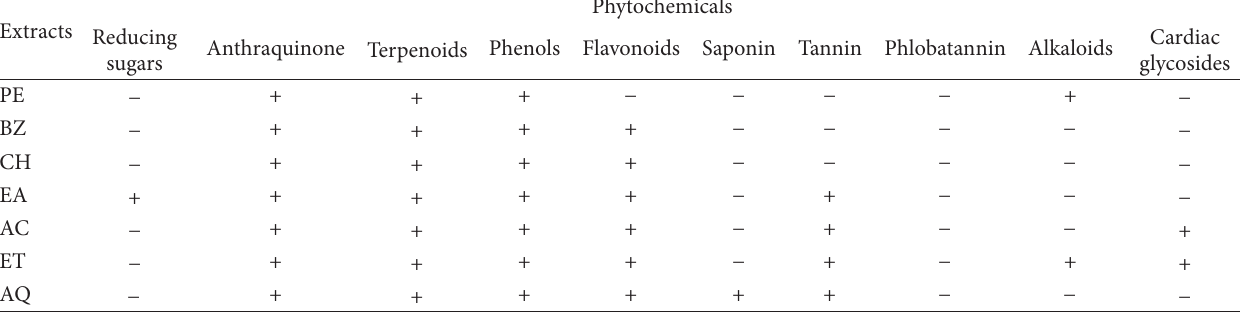
Table 1: Phytochemical profile of T. cordifolia stem extracts.